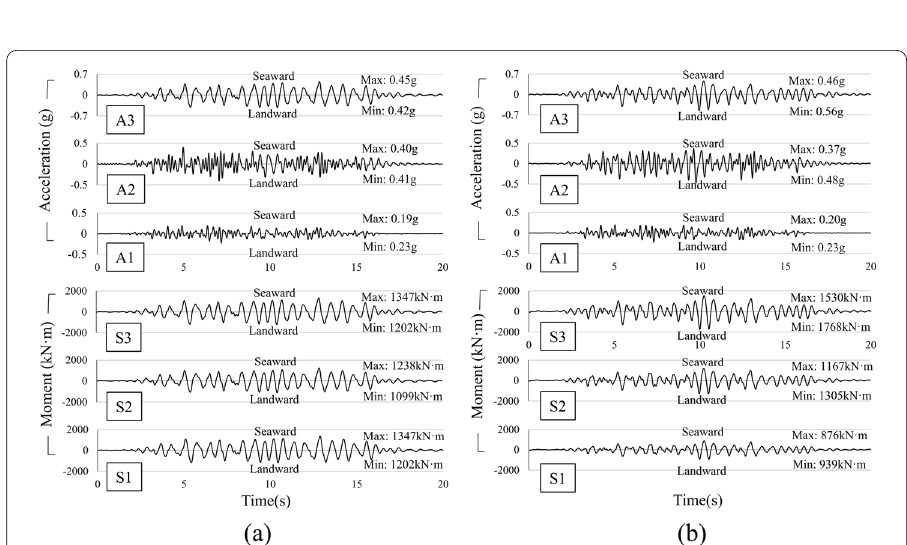
Fig. 6 Time history curves for models a HA45 (0.23 g) and b IA40 (0.23